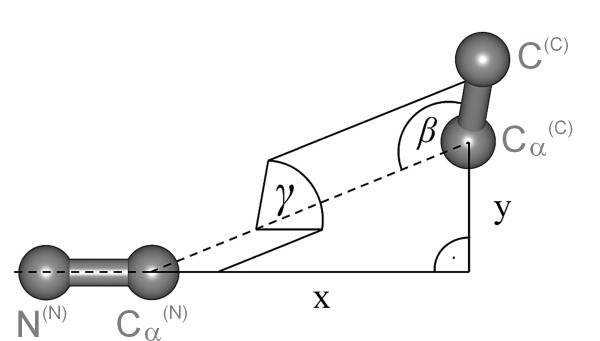
Geometric values that are evaluated and compared during the primary search. Atoms N(N) and Cα(N) are part of the first replaced amino acid; Cα(C) and C(C) are part of the last replaced amino acid on the protein side and are the corresponding atoms on the mimetic side. The x-y plane of the coordinate system is defined by the points N(N), Cα(N) and Cα(C), where the x-axis connects N(N) and Cα(N). The main characteristic values are the distances x and y. Further characteristic values are β, the angle included by the lines connecting the atoms Cα(N) and Cα(C) and also Cα(C) and C(C), and γ, the dihedral angle between the N(N) - Cα(N) - Cα(C) and Cα(N) - Cα(C) -C(C) planes.